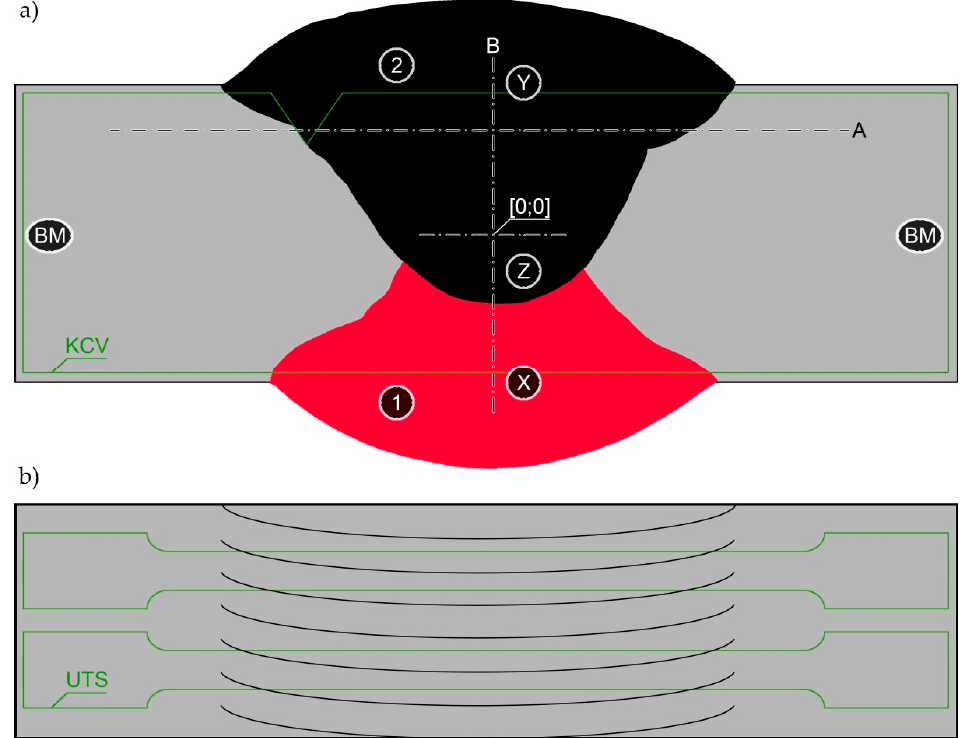
Figure 2. General layout of a Hardox Extreme welded joint: ( a ) cross-section view; ( b ) view from the